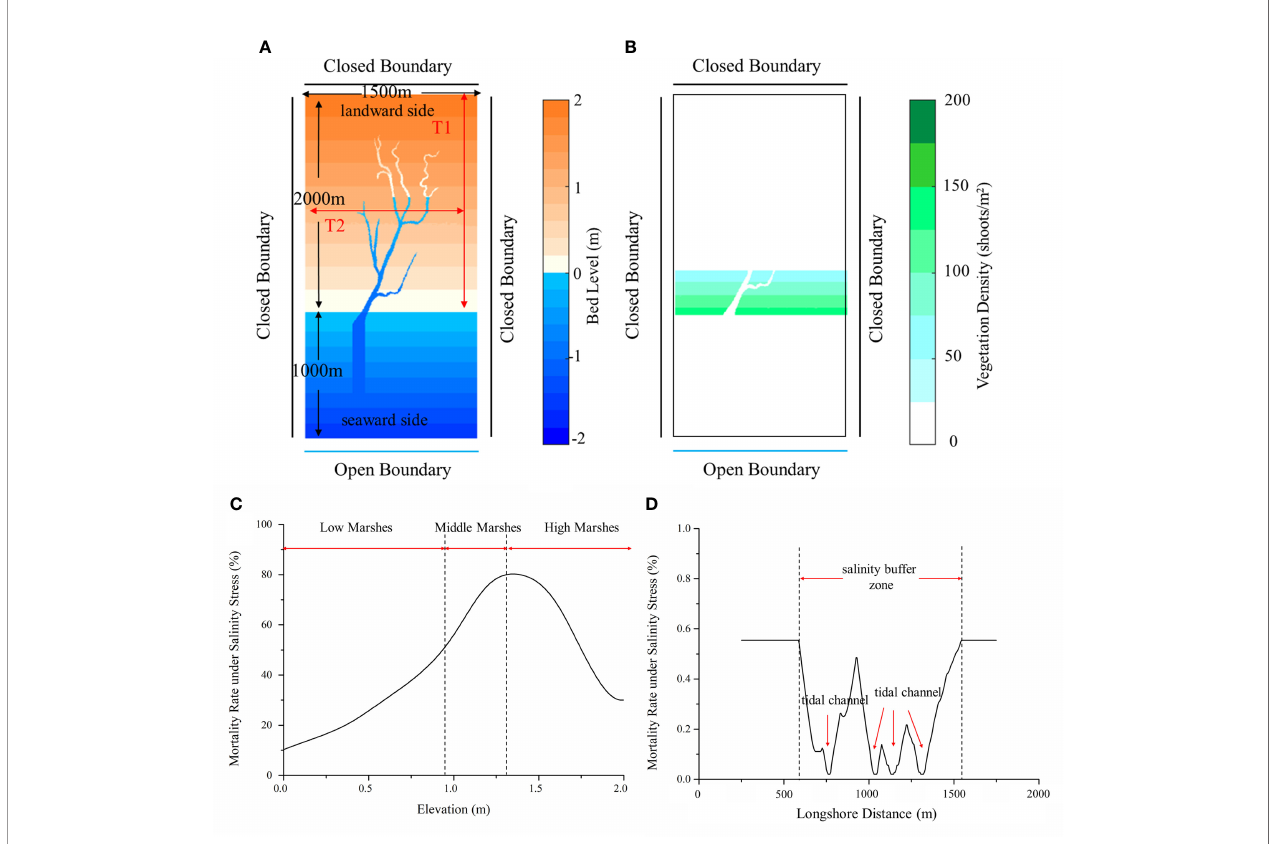
FIGURE 3 | Initial model setting of scenario B: (A) Bed level, domain and boundary conditions; (B) Initial vegetation distribution; (C) Mortality rate under salinity stress along transect 1 (T1) [adapted from Wang et al. (2018)]; (D) Mortality rate under salinity stress along transect 2